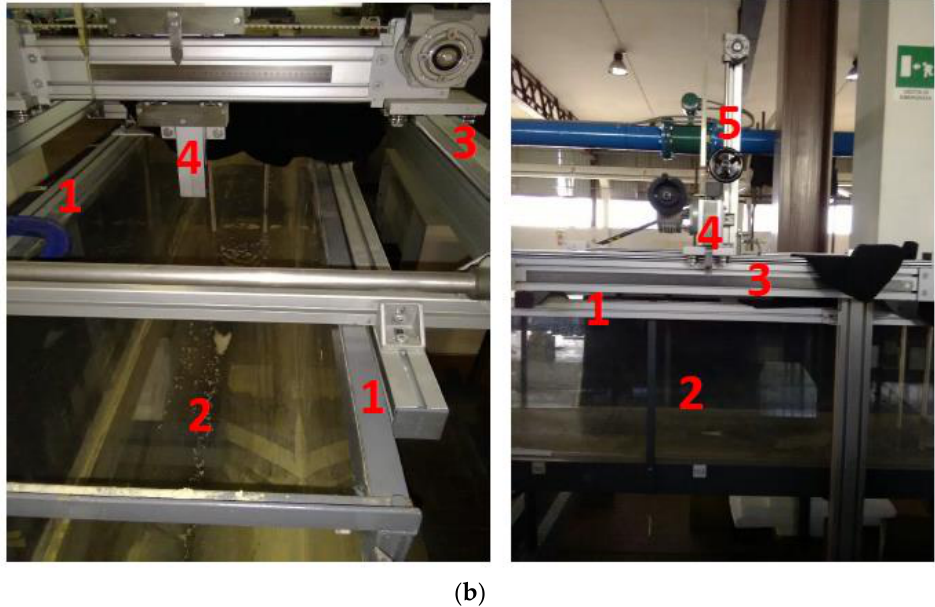
Figure 2. ( a ) NACA 0012 airfoil profile: acquisition probe Vectrino ADV 3D placed in the wake ( left ), and its cross-section ( right ). ( b ) Longitudinal view ( left ), and cross-view of the channel ( right ): channel chassis/skeleton keeping the glass side (1), channel inner part allowing the flow (2), 3D instrument rail (3), head bringing the 3D instrument directed to the channel for measurement (4), vertical rail allowing an up-and-down displacement of the 3D instrument (5).